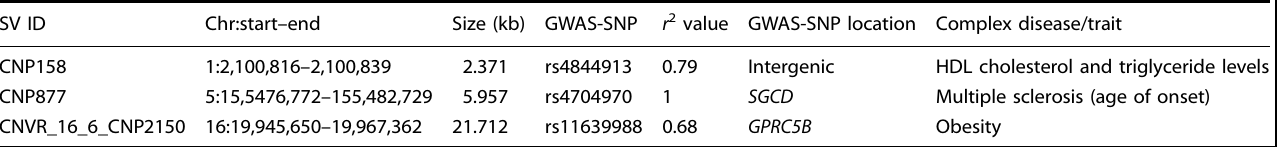
Table 6. Correlation between bi-allelic deletions and GWAS-SNPs at r 2 > 0.5. SV ID Chr:start –